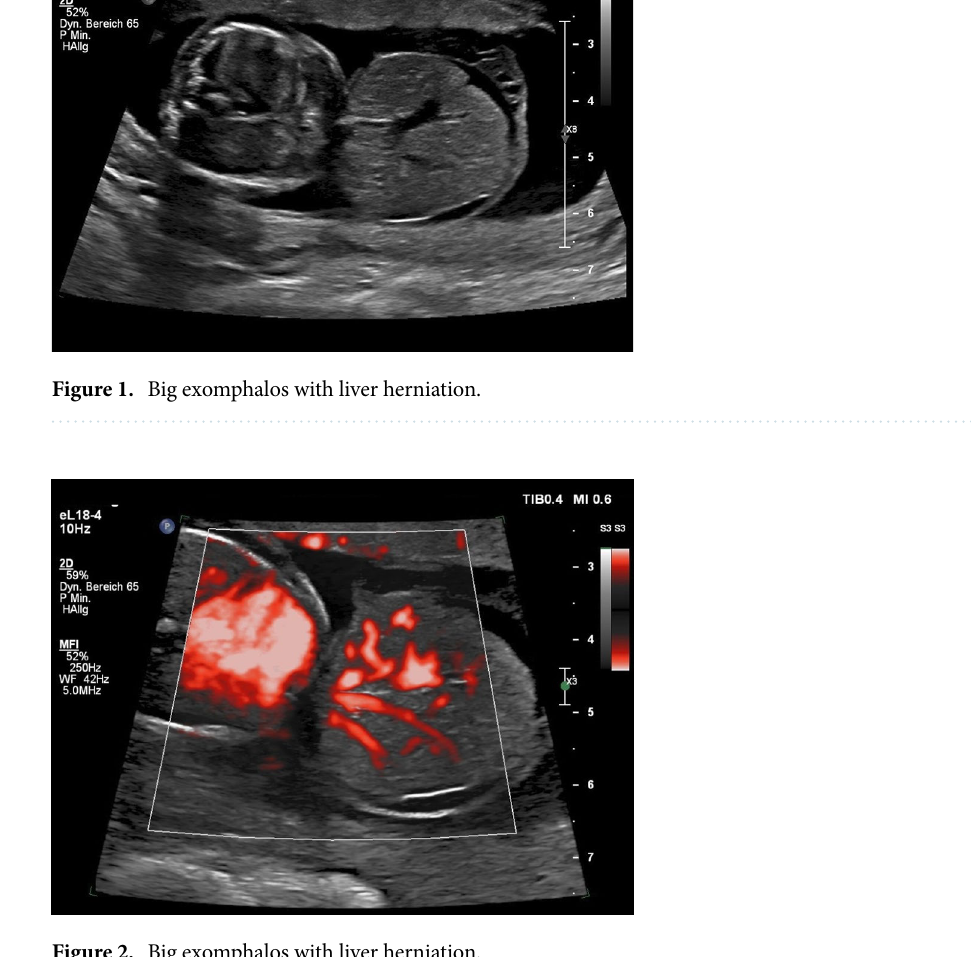
(Figs. 1 and 2). Using one of the saved images after 30 weeks of pregnancy retrospectively, the same examiner performed the following measurements: circumference of exomphalos (EC), anterior to posterior diameter of exomphalos (apED) and maximal diameter of exomphalos (EDmax) (Fig. 3). The following cut-off values were obtained using the fetal abdomen circumference (AC) and head circumference (HC): ED/AC as previously pub- lished by Kleinrouweler et al . 13 ; apED/AC as previously published by Fawley et al . 14 ; EDmax/AC and EDmax/ HC as previously published by Montero et al . 15 . These cut-off values are then used to predict the possibility of a primary closure of the fascia postnatally. The sensitivity, specificity and positive predictive value (PPV) of these values were assessed. The best gestational age of measurement was between 30 and 32 weeks to make a prediction about postnatal primary closure. Excel was used (Microsoft Corporation, Redmond, Washington, USA, 2010) for the statistical analysis. The ethics committee of the Technical University of Dresden, Germany approved this study (BO-EK-66022020, 11 March 2020).